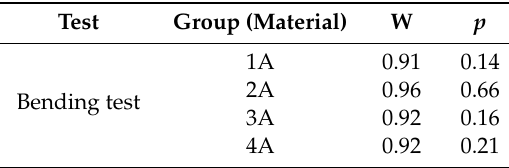
Table 3. Shapiro-Wilk test of the W and p values of the bending strength test results.